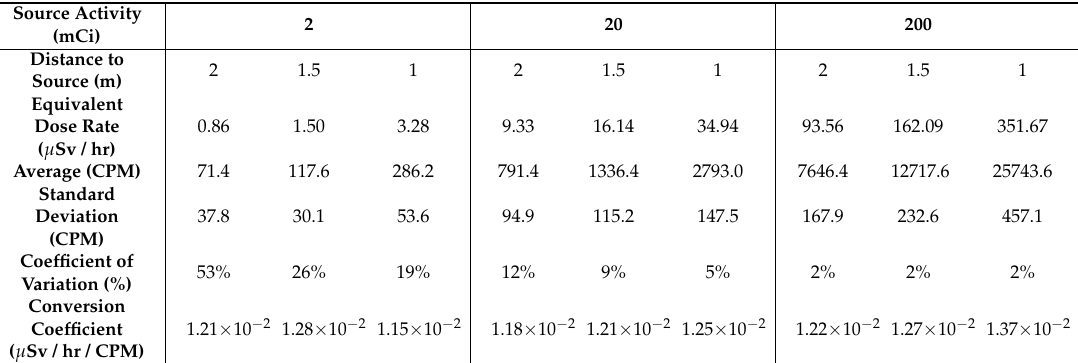
Table 6. Average value, standard deviation, coefficient of variation, and conversion coefficient of each acquired set of 20 values for the Sparkfun, considering each source-distance configuration. Background acquisition had an average value of 16.8 CPM and a standard deviation of 12.6 CPM.